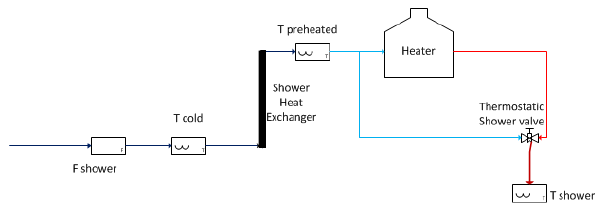
Figure 4. Flow diagram of the laboratory configuration (F is flow meter, T is temperature